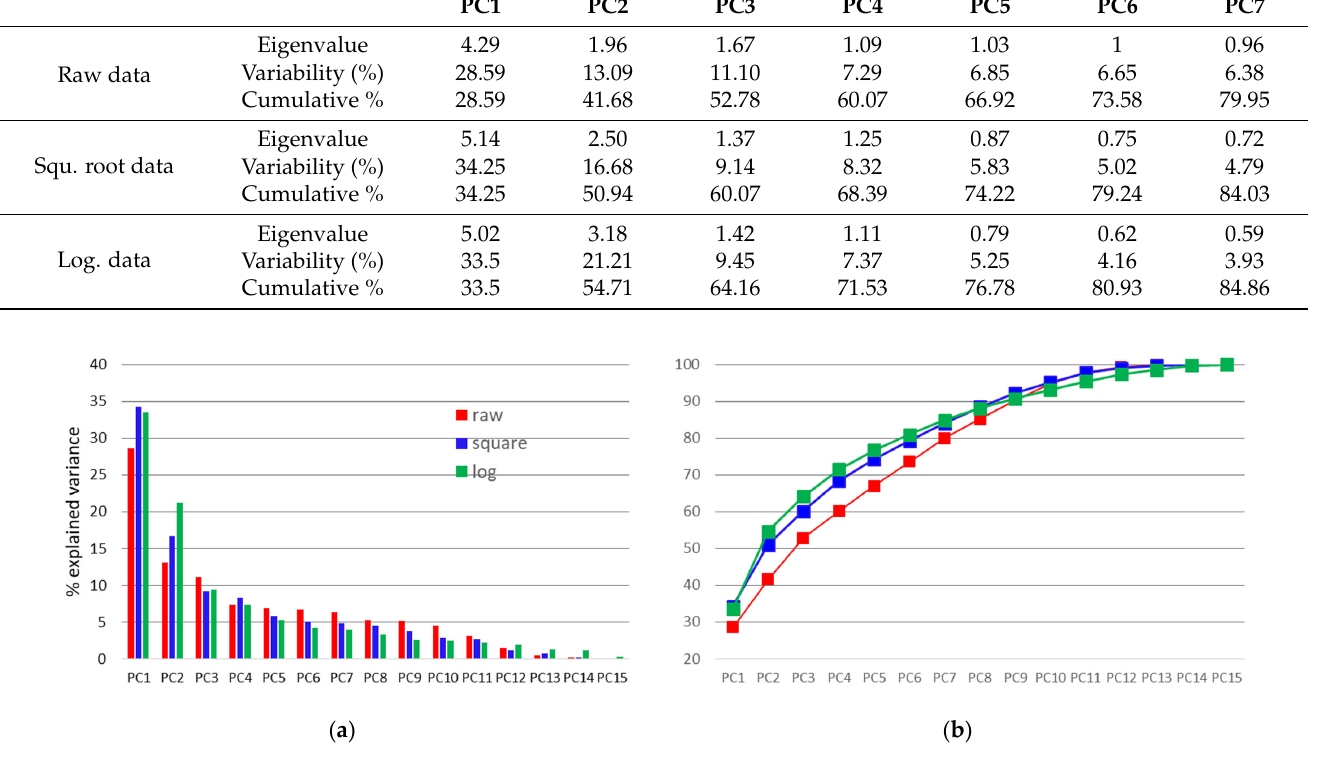
Figure 4. Variance ( a ) and cumulative variance ( b ) explained by the principal components using raw data, square root and logarithm transformation. Table 3. Table of variances for PC 1 to PC7 and 3 conditioning modes.